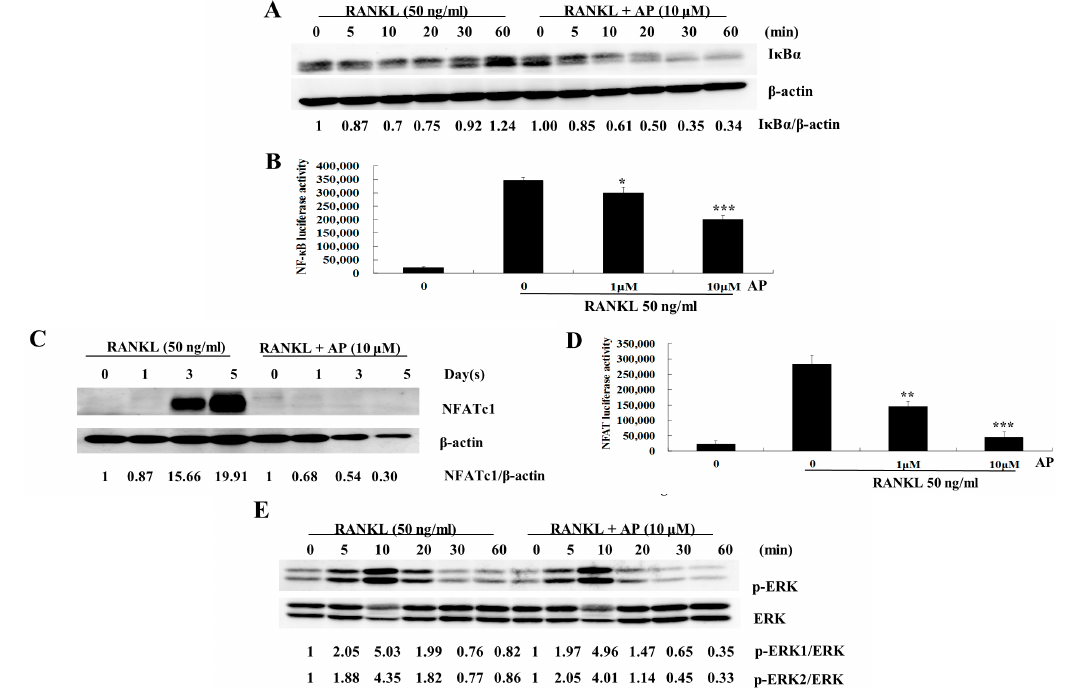
Figure 4. Andrographolide inhibits RANKL-induced NF- κ B and NFATc1 activities. ( A ) BMM were seeded at a density of 5 × 10 5 per well. After attachment overnight, cells were pre-treated with AP for 1 h and then stimulated with M-CSF (25 ng/mL) and RANKL (50 ng/mL) for indicated times. Lysate of cells were collected by using RIPA Lysis Buffer, and separated with 10% SDS-PAGE following by transferring onto nitrocellulose membrane. The membrane was blocked and probed with antibodies to I κ B α and β -actin. Signal intensities of bands were detected, and shown as a ratio of I κ B α / β -actin; ( B ) RAW 264.7 cells, which transfected with 3 κ B-Luc-SV40 reporter gene, were pre-treated with one or 10 µ M AP for 1 h followed by RANKL stimulation for 6 h. Cell lysates were collected and examined for luciferase activity; ( C ) BMMs were treated with AP (10 µ M) and stimulated with and M-CSF and RANKL for indicated times. Cell lysates were collected for Western blot analysis using antibodies to NFATc1 and β -actin; ( D ) RAW 264.7 cells stably transfected with an NFATc1 luciferase reporter construct were cultured with AP at one or 10 µ M in the presence of RANKL. Luciferase activity was measured after 24 h; and ( E ) BMMs were treated with AP (10 µ M), and stimulated with RANKL (50 ng/mL). Cell lysates were analyzed by Western blot with antibodies to ERK and p-ERK. All experiments were run in triplicate. Student’s t-test was used for statistical analysis. * p < 0.05; ** p < 0.005; *** p < 0.001.